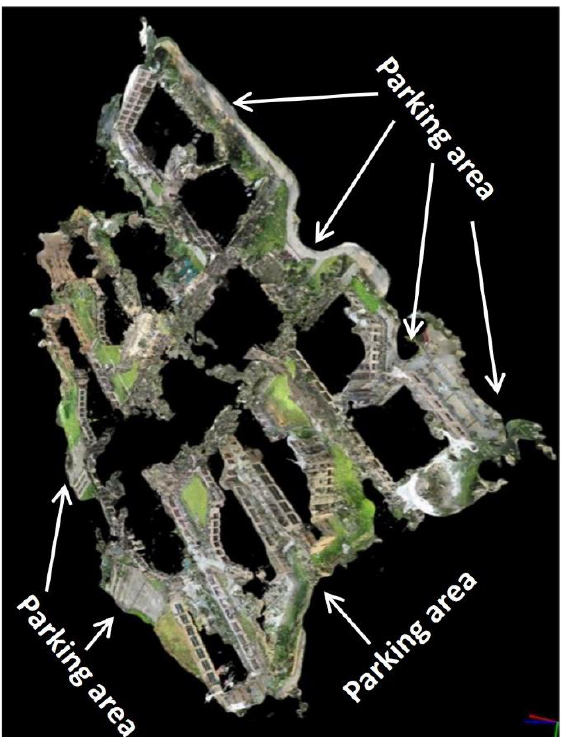
Figure 6. Low resolution 3D point cloud of study site showing parking